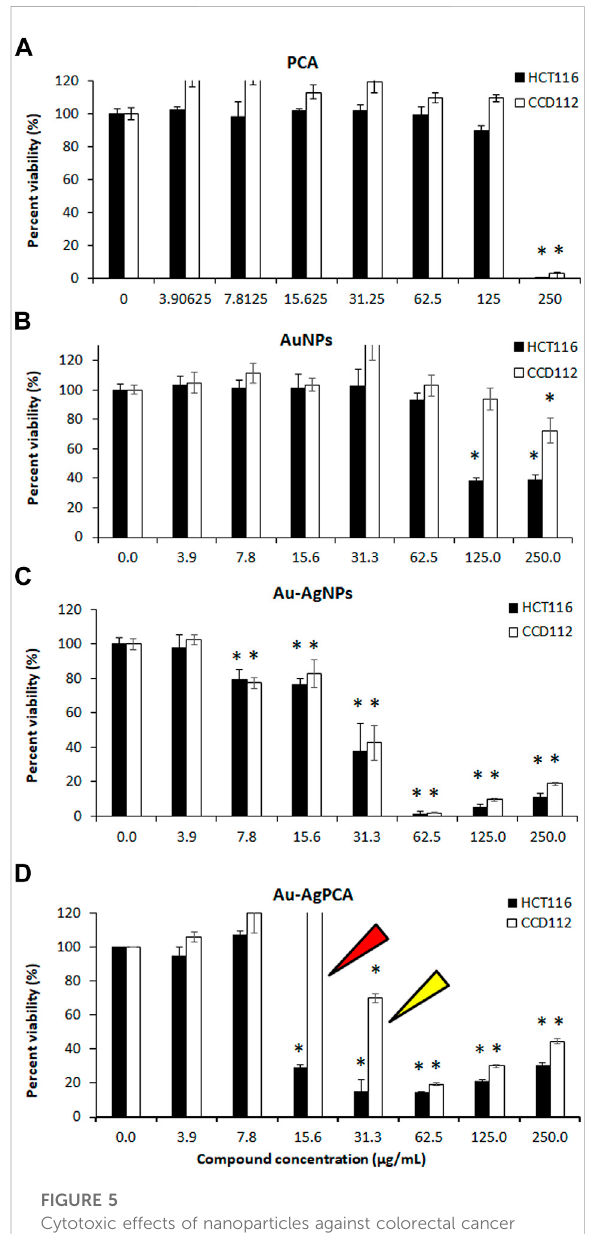
FIGURE 5 Cytotoxic effects of nanoparticles against colorectal cancer (HCT116)andcolonnormal(CCD112) celllines. (A) protocatechuic acid (PCA); (B) AuNPs; (C) Au-AgNPs and (D) Au-AgPCA. Arrows show speci fi c cytotoxicity of Au-AgPCA on cancer cells but not in normal cells. Data are expressed as mean ± standard deviation for triplicates within an individual experiment. Statistical signi fi cance was performed using Student ’ s t -test. (* p <